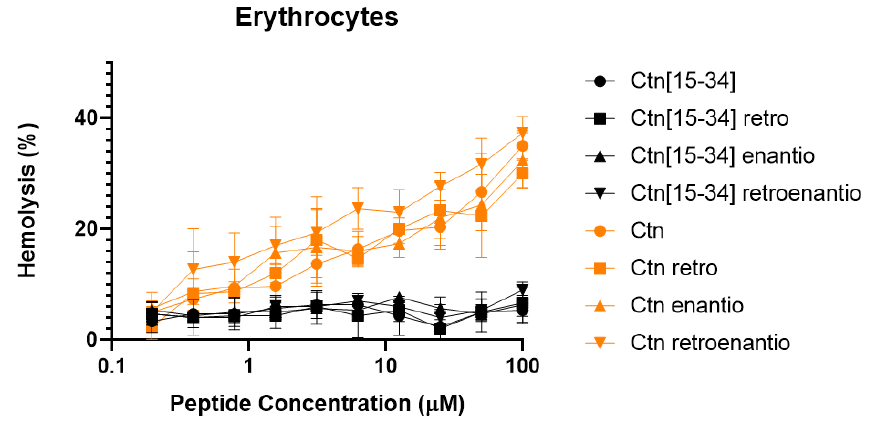
Figure 4. Hemolysis data of Ctn and Ctn[15-34]